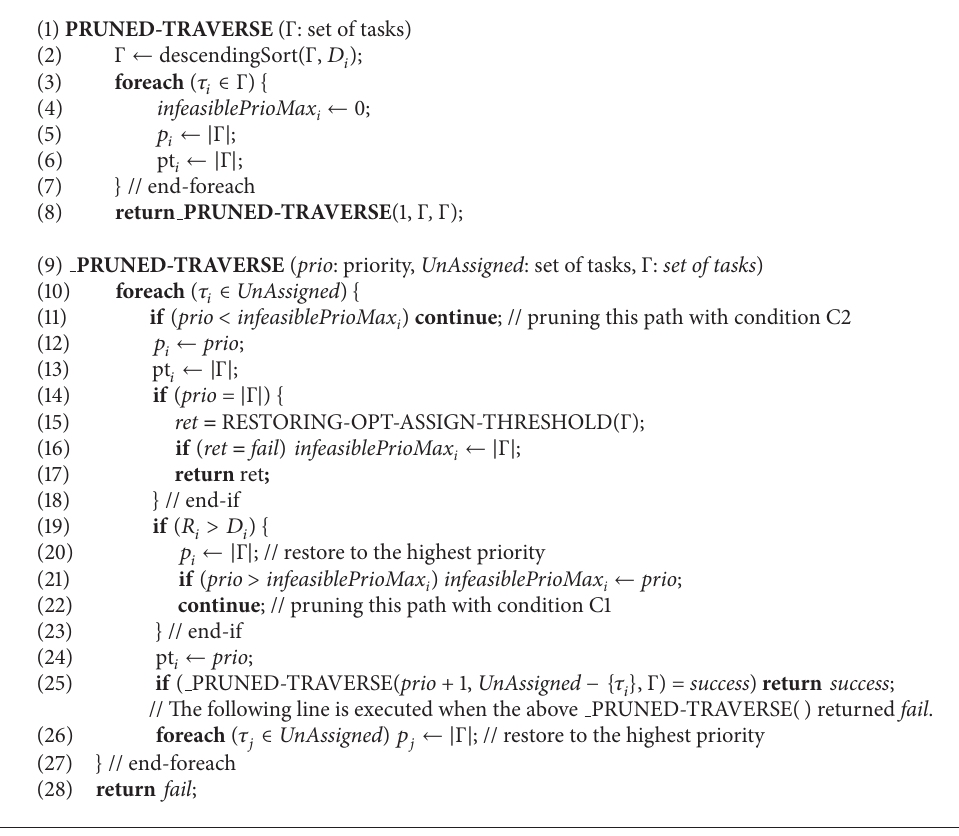
Algorithm 3: Pseudo code for the proposed PRUNED-TRAVERSE( )